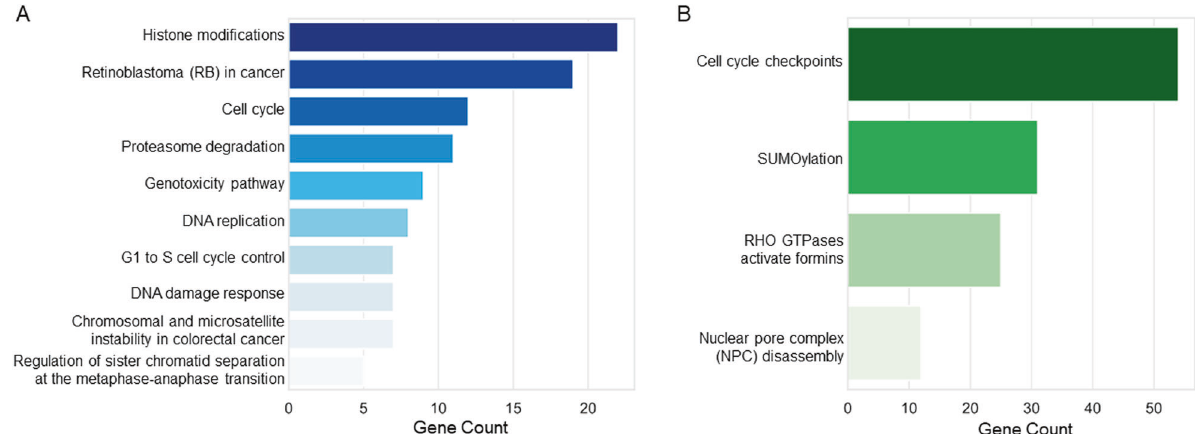
Fig. 6 Pathways deregulated by TTFields. A Pathways shared by epithelioid and sarcomatoid cells. B Pathways exclusively modulated in the epithelioid CD473